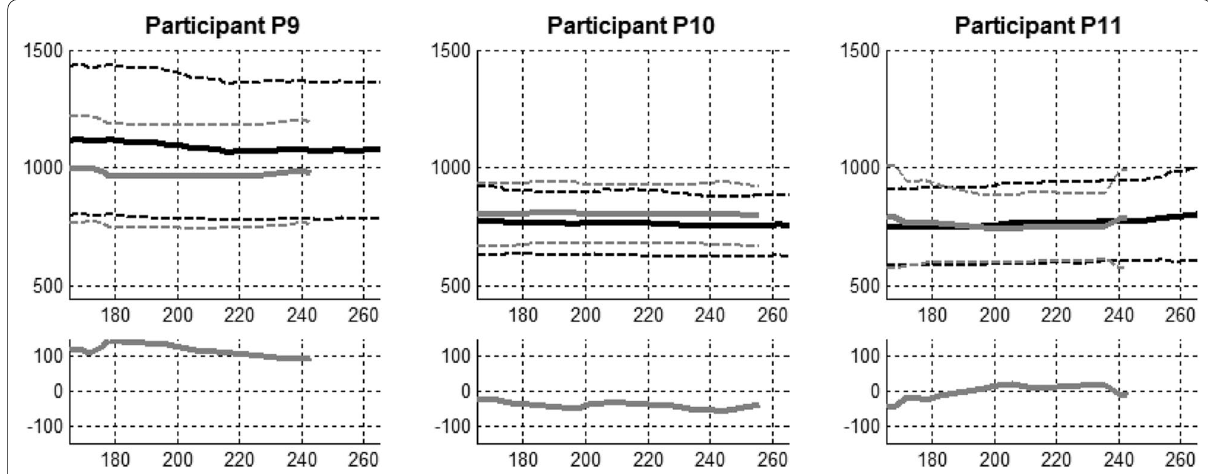
Fig. 2 Running average of RT for conditions G (coloured in black) and NG (coloured in gray) in the 12 participants. Solid lines in the upper plots are the means at every condition (black for standard target condition and gray for noisy target). In the bottom plots the difference of the RTs between G and NG is